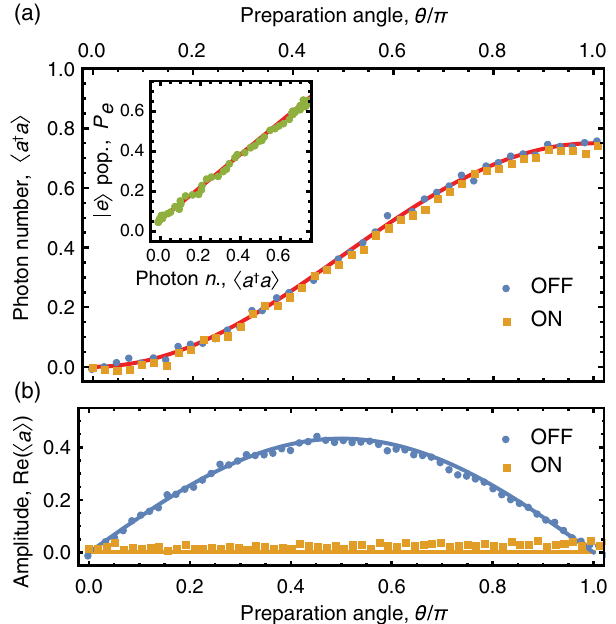
FIG. 4. Nondemolition character of the measurement. (a) Power, reported as photon number h a † a i , is conserved, while (b) phase, measured as optimized quadrature Re ðh a iÞ , is erased. Solid lines are the expected response of a QND detector. (a, inset) Measurement of the excited-state population P vs the average e outgoing photon number h a † a i , with the expected dependence P P ð e j 0 Þ þ F a † a i e ¼ in h